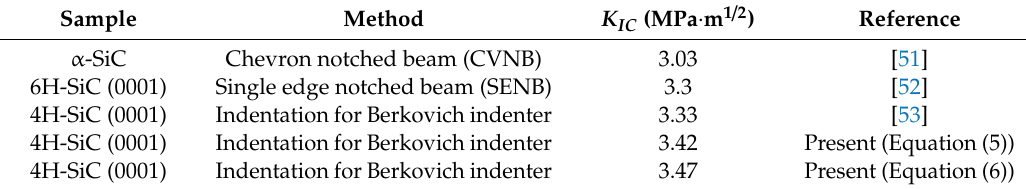
Table 5. The fracture toughness of SiC measured by di ff erent